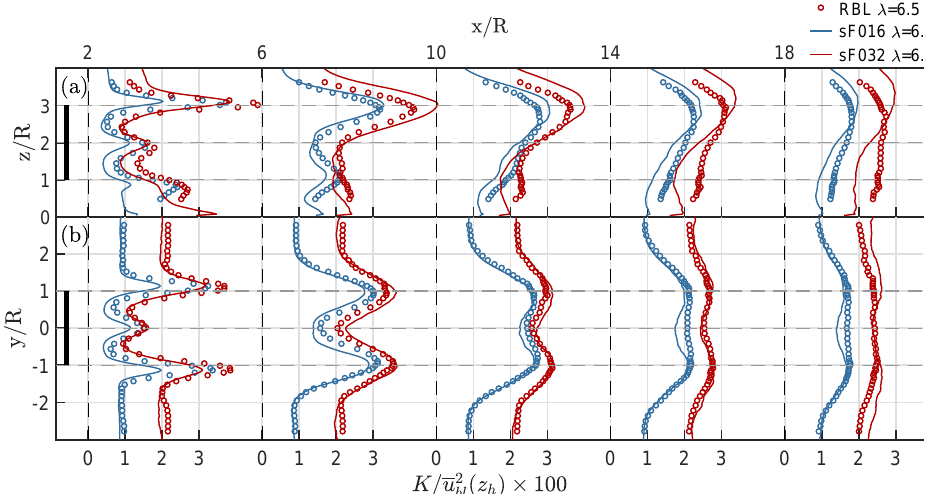
Figure 14. Profiles of the normalized turbulent kinetic energy K / u 2 ( b ) mid − horizontal plane at axial positions x / R = 2, 6, 10, 14, 18. Symbols denote measurements, whereas lines correspond to LES results. The legend denotes the